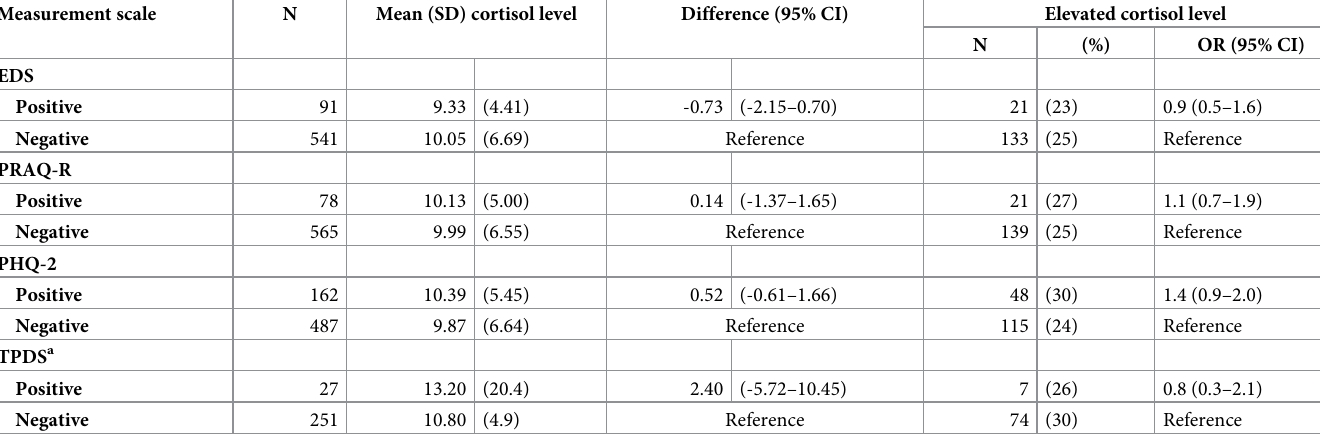
Table 1. Comparison of awakening salivary cortisol levels between women who scored positive and negative on the different measurement scales. Data from the PRIDE Study,